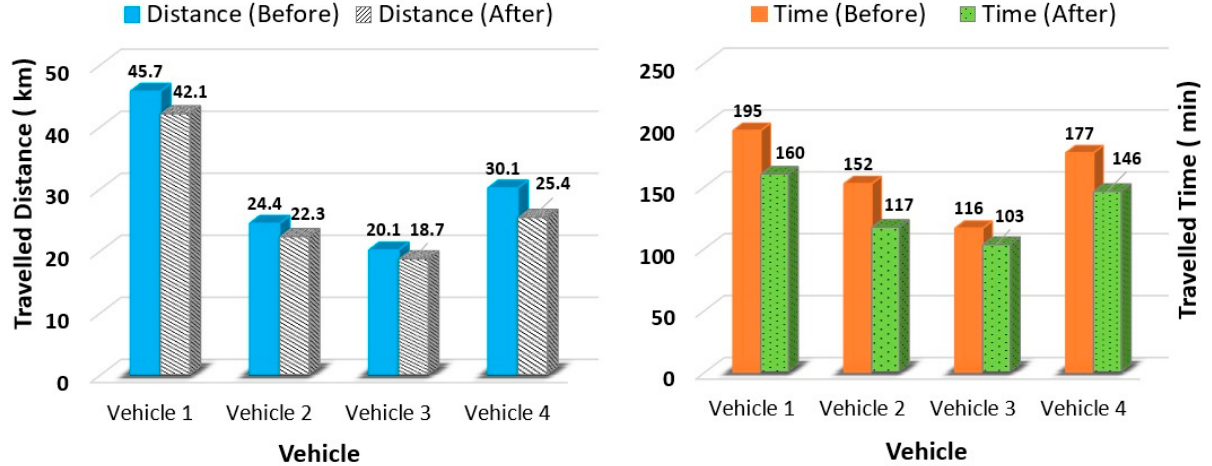
Figure 11. Comparison of total traveling distance and time.